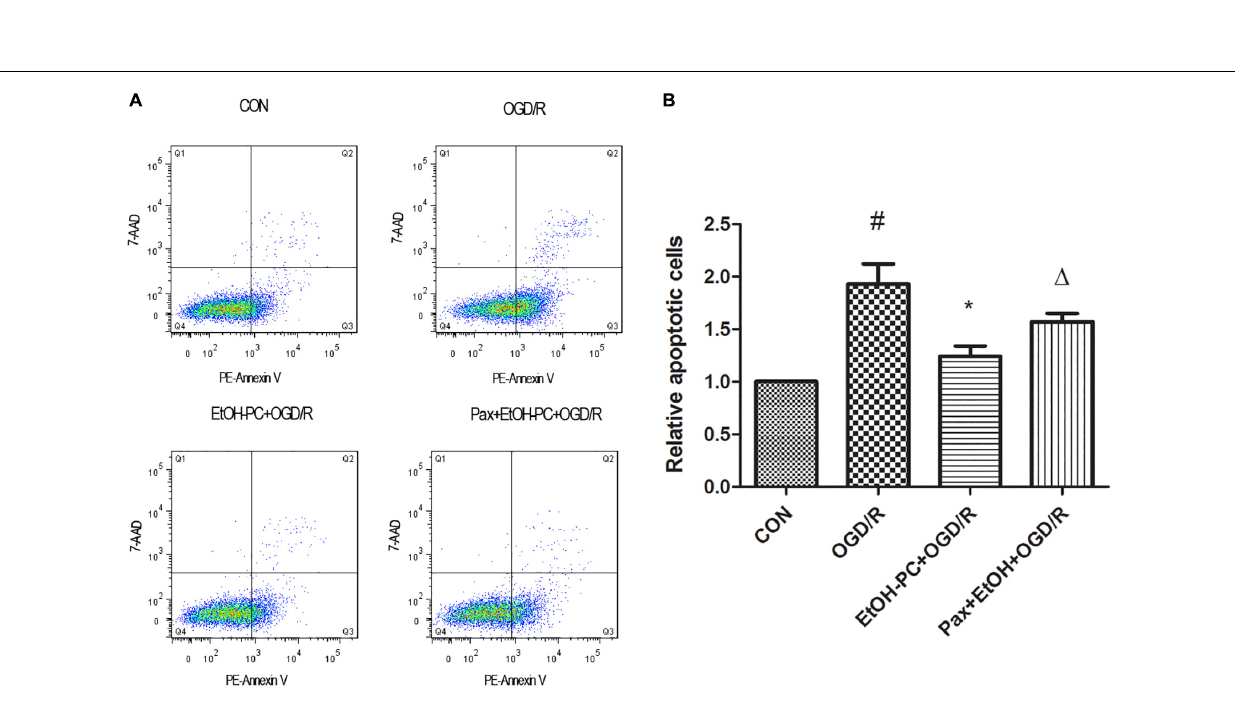
Frontiers in Physiology |